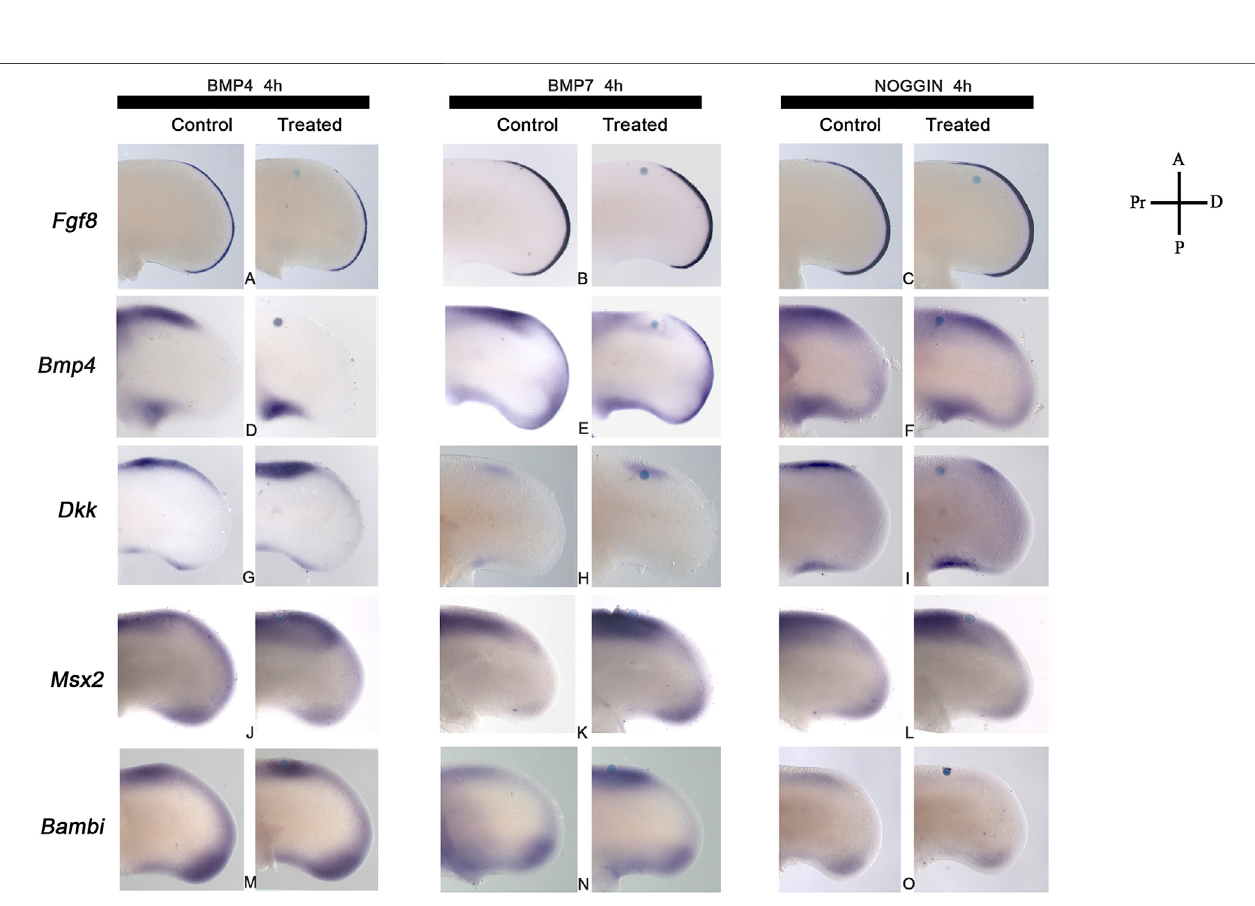
FIGURE 5 | BMP signaling regulates Fgf8, Bmp4, Dkk, Msx2, and Bambi gene expression. Regulation of (A – C) Fgf8 , (D – F) Bmp4, (G – I) Dkk, (J – L) Msx2, (M – O) Bambi geneexpressionintheanteriorlimbmarginafterBMP4,BMP7,orNoggin. Fgf8 (B,C) andBmp4 (D,E) aredownregulatedafter4 hofBMP4orBMP7.Noticethe stronger effect of BMP4 than BMP7. In contrast, NOGGIN-treatment maintained the expression of both genes after treatments. (G – I) Upregulation of Dkk gene expressionafter4 hofBMP4-orBMP7-treatmentanddownregulationof Dkk after4 hofNOGGINtreatment. (J – L) Msx2 and (M – O) Bambi geneexpressionwere upregulated by BMP4 and BMP7. In contrast, NOGGIN inhibited Bambi expression during the fi rst 4 h of treatment but not Msx2 [Panel (L, O) ].